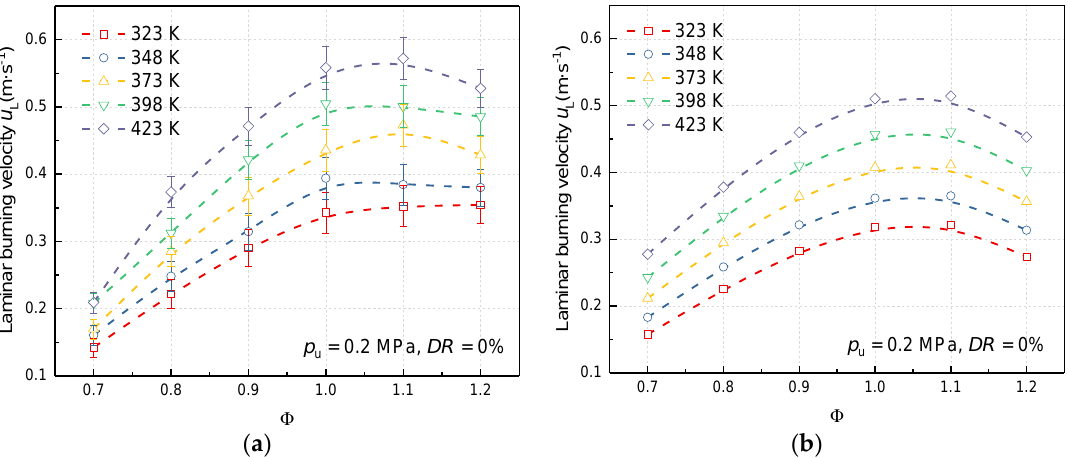
Figure 4. Laminar burning velocities under different initial temperatures (initial pressure of 0.2 MPa, dilution rate of 0%). ( a ) From Schlieren; ( b ) From Chemkin.